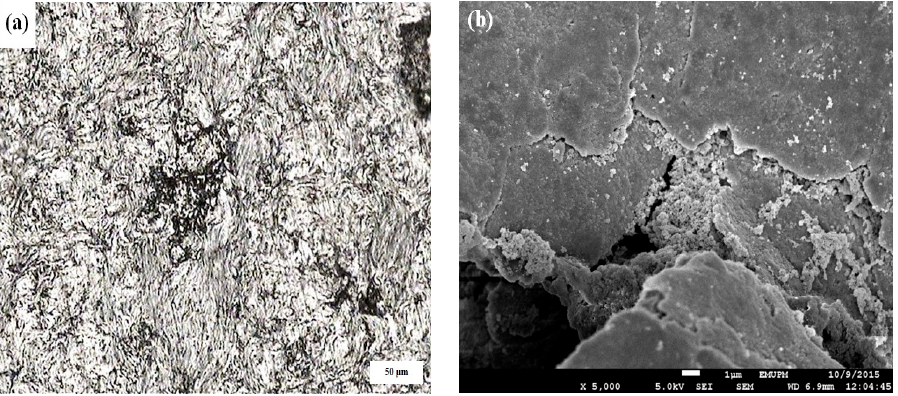
Figure 7. ( a ) Optical micrograph and ( b ) FESEM micrograph of the surface of Al-5Al 2 O 3 nanocomposite milled for 2 h.